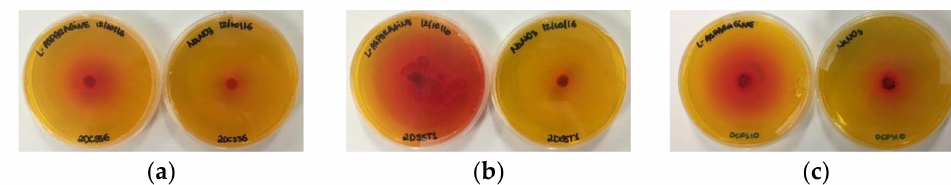
Figure 1. Semi-quantitative screening of the L -asparaginase production of fungi isolated from the Brazilian Savanna in a solid medium supplemented with phenol red containing a single source of nitrogen ( L -asparagine or sodium nitrate). The presence of a red halo on the plates represents the potential of high L -asparaginase production. L -asparagine as enzyme substrate (left) and sodium nitrate as control (right): ( a ) 2DCSS6; ( b ) 2DSST1; ( c ) DCFS10. Out of the 39 isolates from the Brazilian Savanna soil and plants, 27 showed growth on L -asparagine media after 48 h of incubation, of which 14 (14/27) isolates showed a zone diameter twice the colony diameter (index > 2): two Aspergillus isolates (DCFS1 and 2DCSS6), eight Penicillium isolates (DCFS6, RCFS24, 2DSST1, 2DMGSE2, RCFS6, 2DSST10, RCFT14 and DCFF2), one Fusarium isolate (DCFS10) and three unidentified endophytes